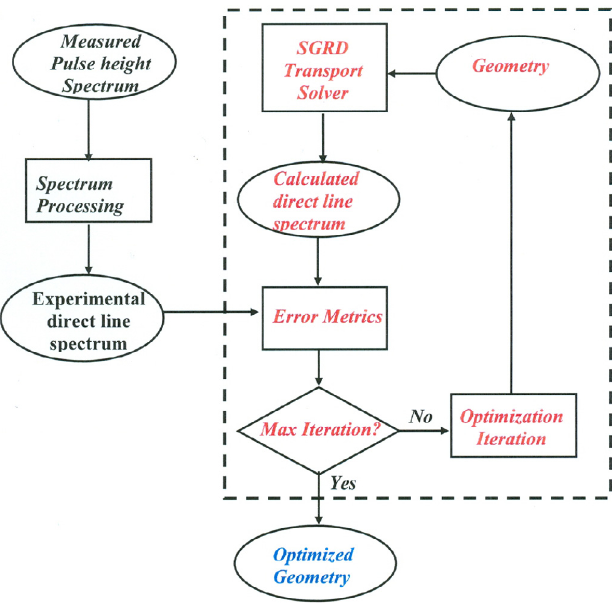
Fig. 12. Inverse transport for geometry search using SGaRD ray tracing solver.